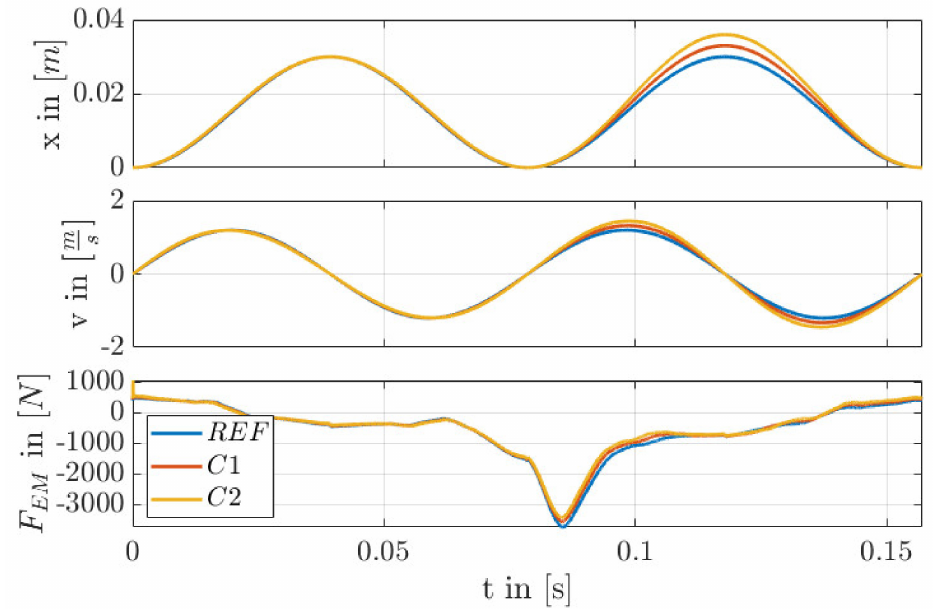
Figure 27. Comparison of trajectories REF, C1 and C2 related to the energy conversion of the electrical machine: illustration of the stroke, velocity and electric machine force depending on